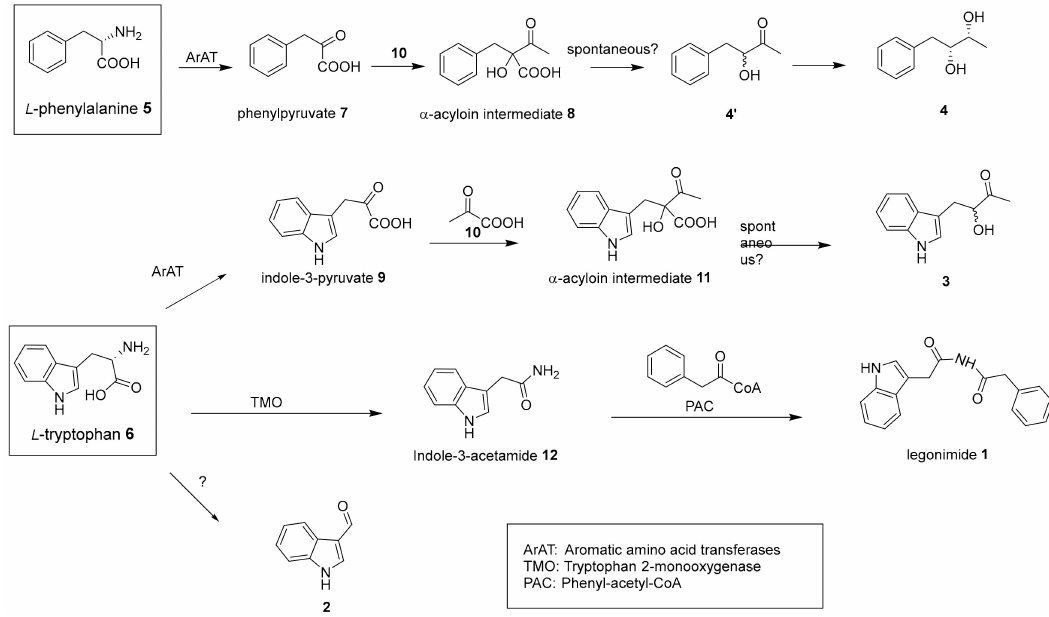
Figure 2. Proposed biosynthesis pathway of 1 –